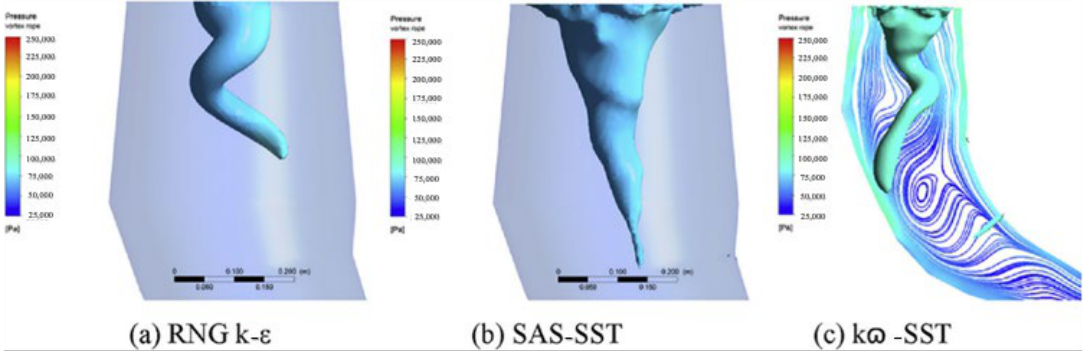
Figure 7. Influence of turbulence model on draft tube vortex rope shape [39].